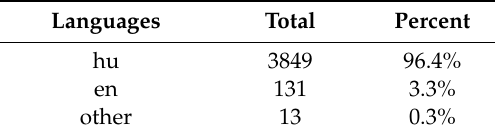
Table A25. Primary languages (hu).